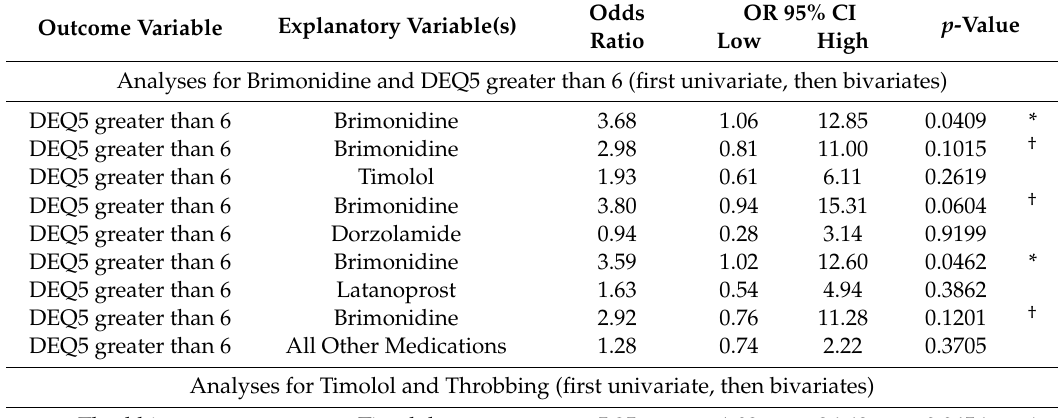
Table 3. Odds ratios for univariate and bivariate logistic regression